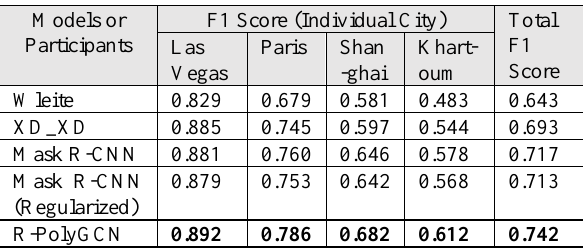
Table 5.4: F1-scores of Building Extraction